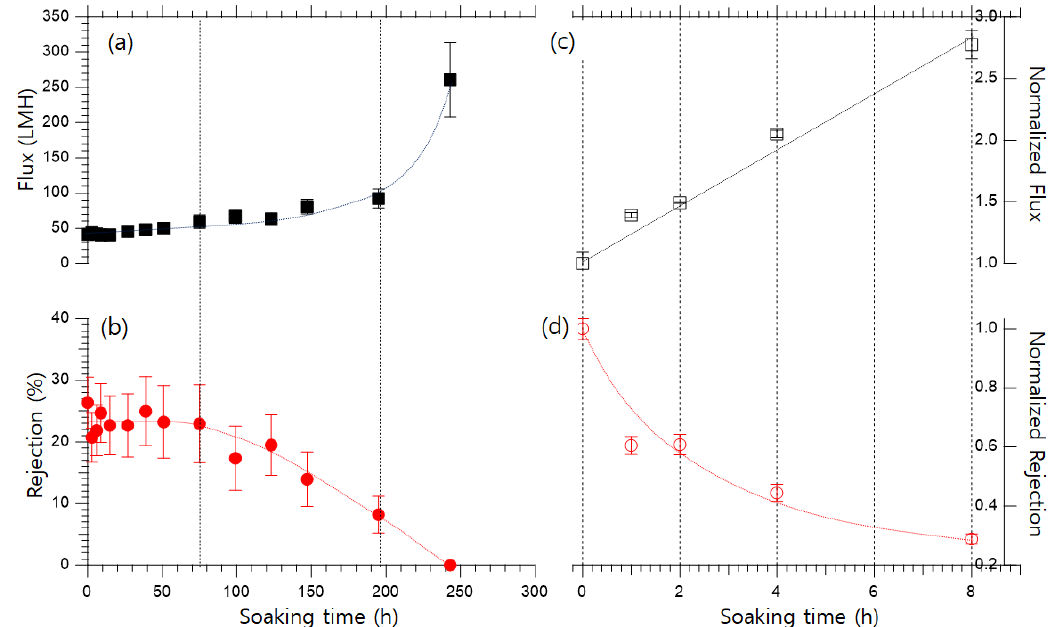
Figure 2. ( a ) Flux and ( b ) MgSO 4 rejection of the PI membrane after long-term exposure to 15 w / v % H 2 SO 4 . ( c ) Normalized flux and ( d ) normalized rejection of the PI membrane after exposure to 50 w / v % H 2 SO 4 .